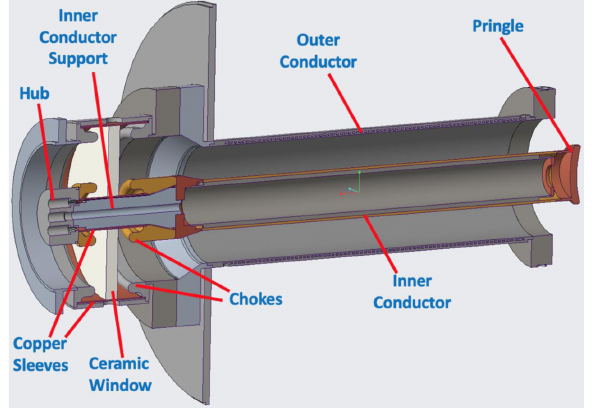
FIG. 10. Mechanical simulation model.